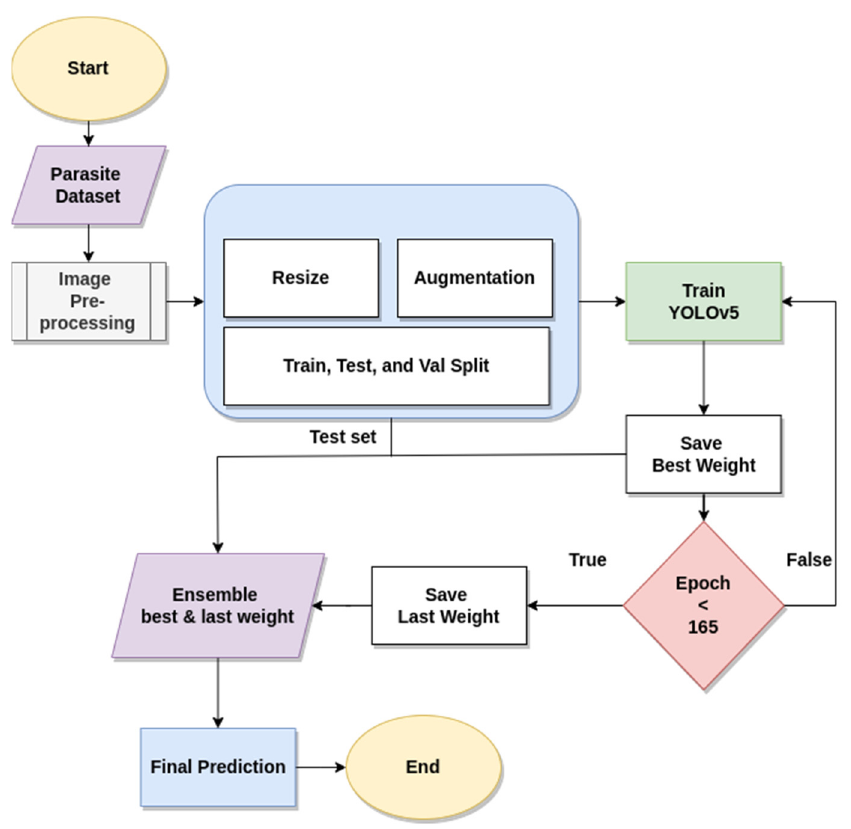
Figure 5. Flow chart for Proposed